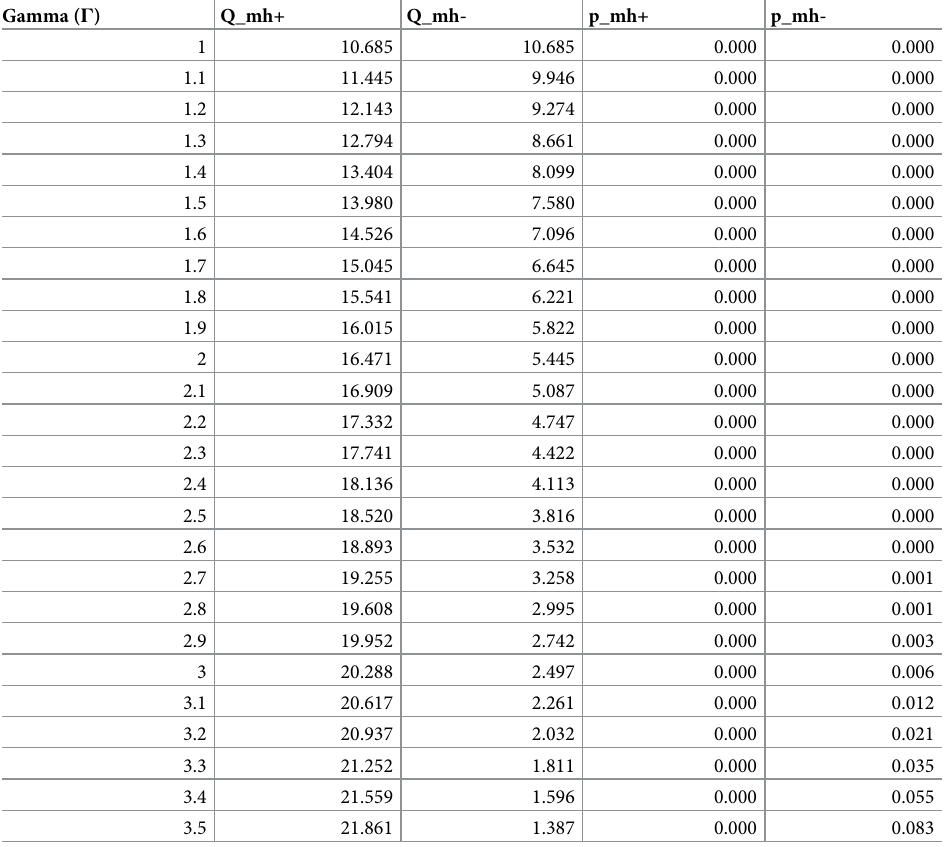
Table 3. Bias analysis of sensitivity to unmeasured